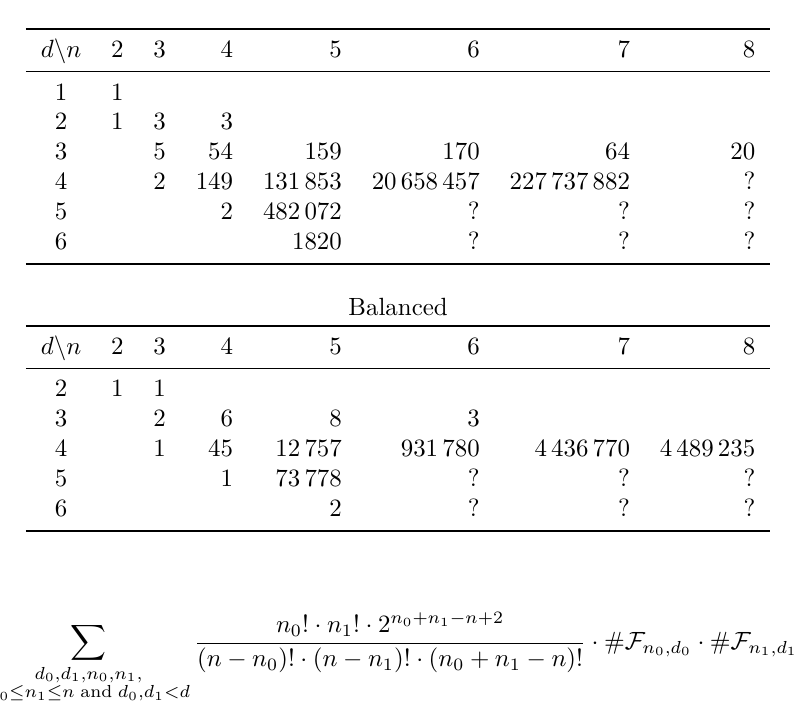
Table 3: Number of full-dependent n -bit (balanced) Boolean functions with latency complexity d up to the extended bit